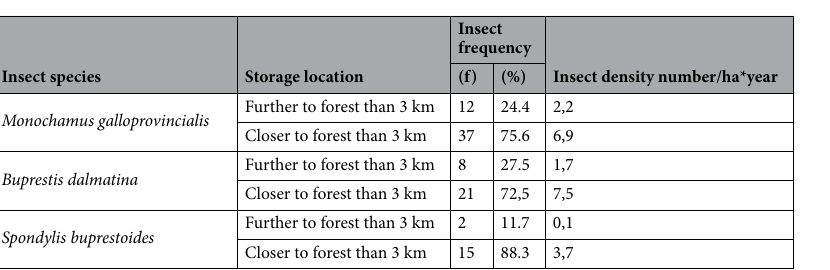
Table 4. The frequency, and insect density depending on distances to forested